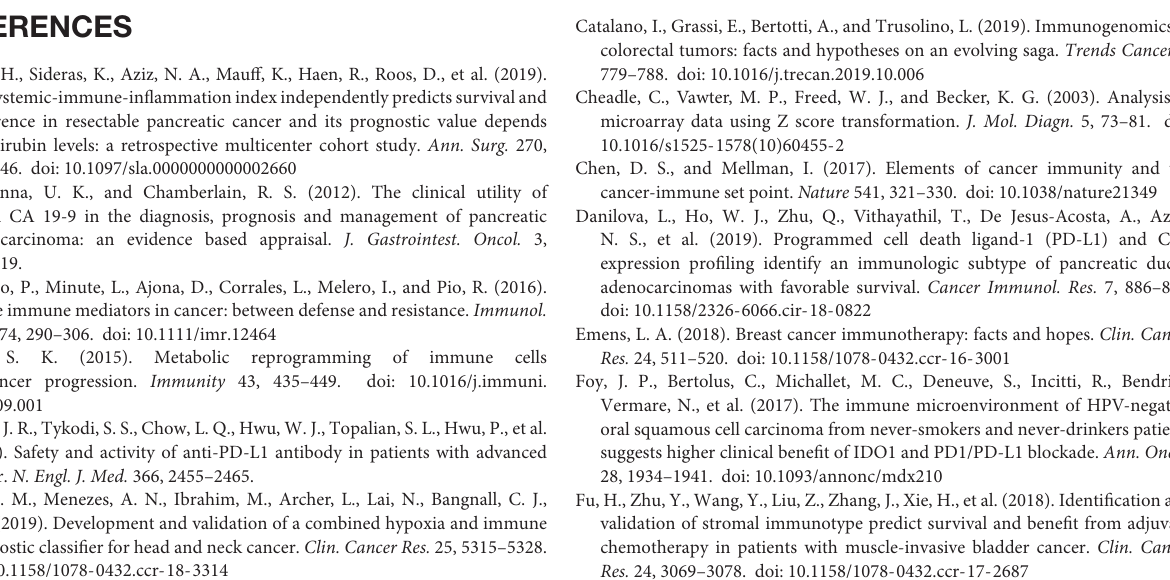
Supplementary Table 5 | The gene name of each row from the heatmap in Figure 7B